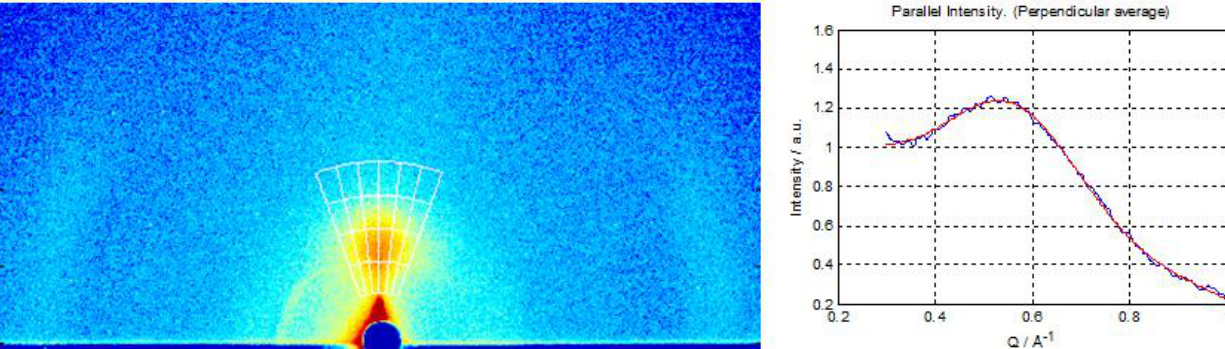
Figure 6. Left: The GIWAXS data as measured, with intensities represented on a color log scale. The strongest scattering feature near the center of the image corresponds to the 001 reflection, whereas the weaker scattering at the edges of the image, correspond to the 110 and 11-1 reflections [22], showing that the crystallites are preferentially oriented with the ab-plane parallel to the substrate surface. Right: Integration over 001 peak, assuming sample to detector distance of 121 mm, yields a d-spacing of 11.1 Å.